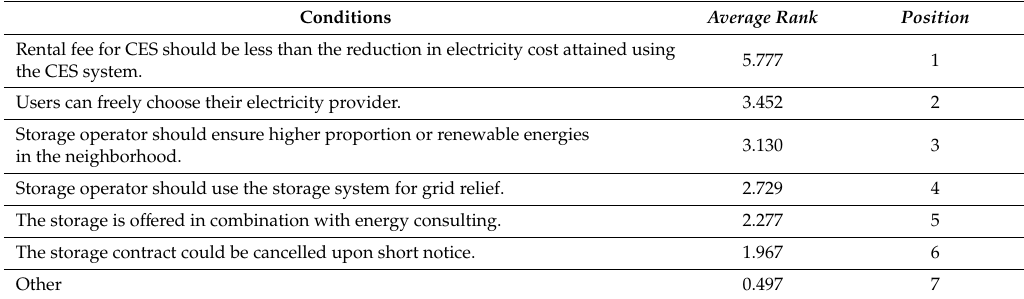
Table 3. Conditions for being interested in participating in a CES system (N = 332). Conditions Average Rank